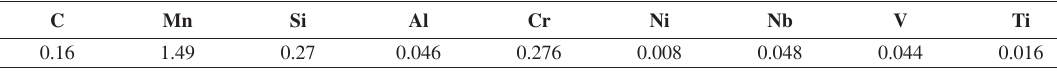
Table 1. Chemical composition of the low-carbon steel (% weight).